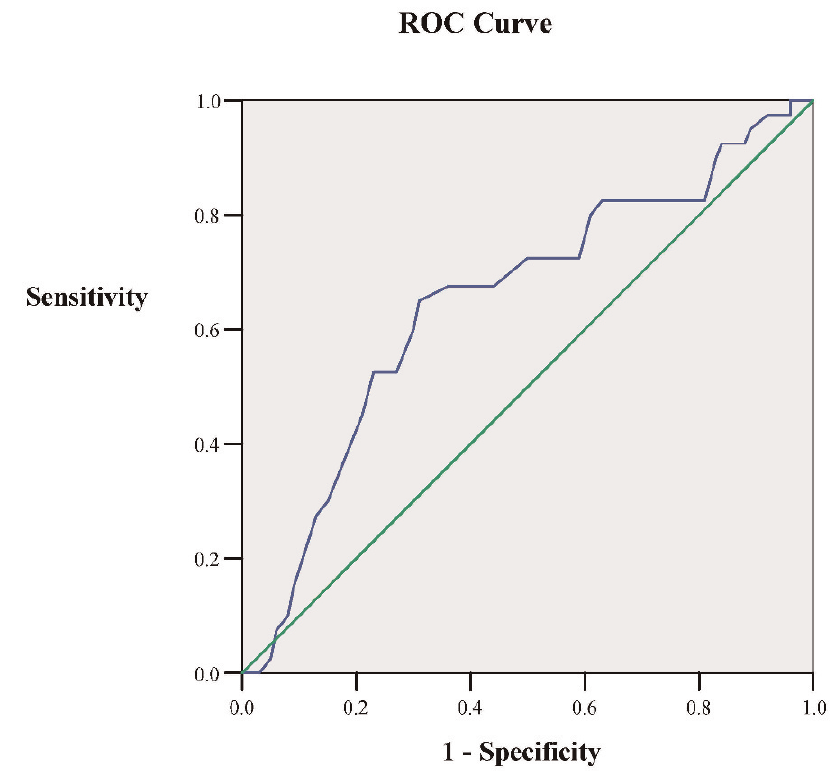
Figure 2 - Receiver operating characteristic (ROC) curve analysis for prediction of NSTEMI by red blood cell distribution width (RDW). The area under the curve (AUC) is 0.649 (95% confidence interval: 0.546-0.753; p , 0.001) for